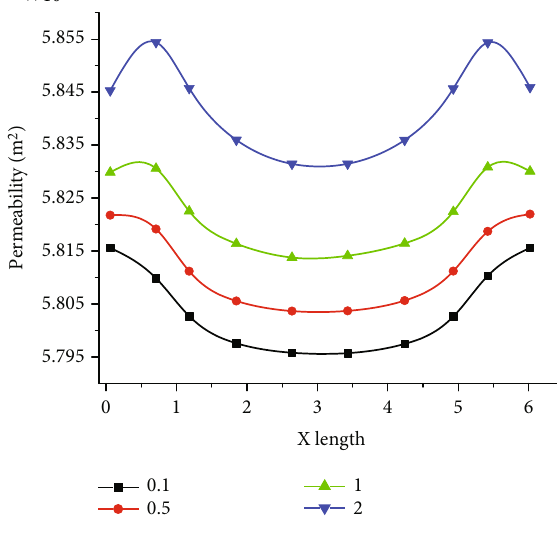
Figure 13: The permeability distribution at di ff erent depths in the m - n